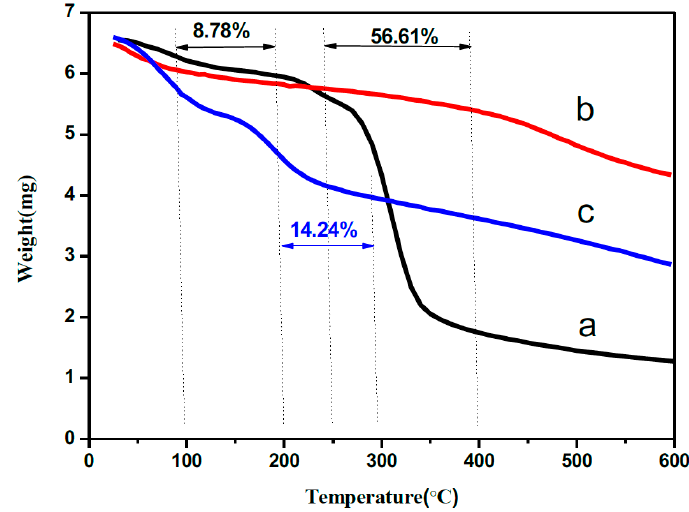
Figure 6. Thermogravimetric analysis (TGA) profiles of sweet potato (a); carbonized carrier (b) and sulfonated carbon-based solid catalyst (c).